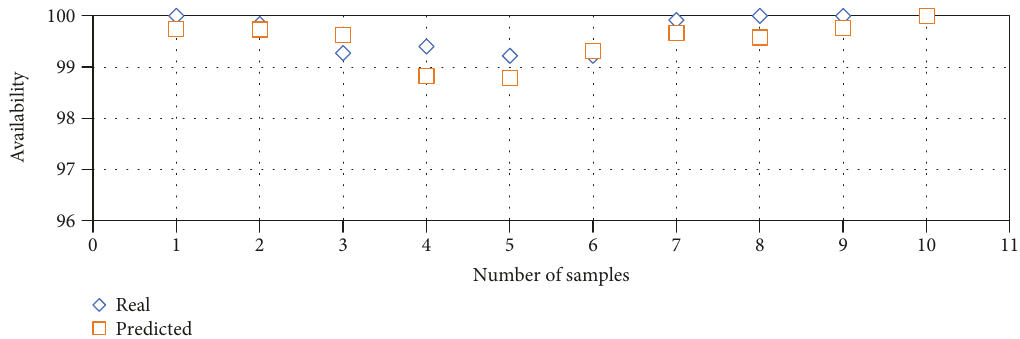
Figure 3: Comparison of the forecast and actual availability of the